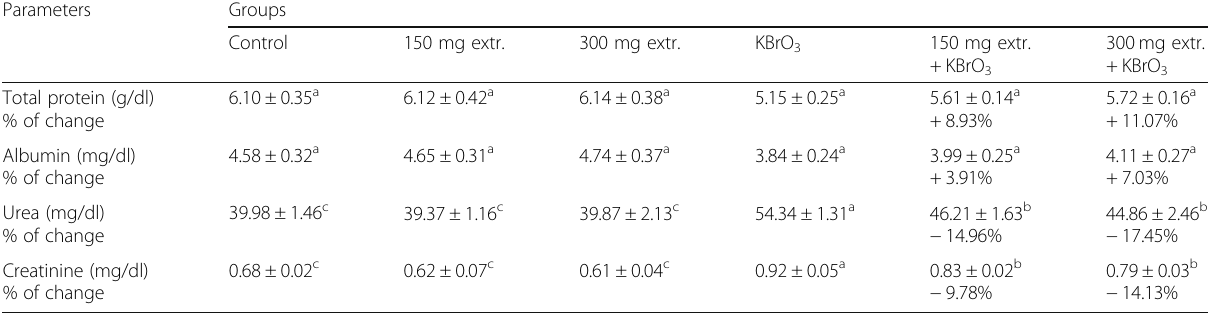
Table 2 Effect of potassium bromate and/or strawberry leaves extract on serum total protein, albumin, urea and creatinine levels of different rat